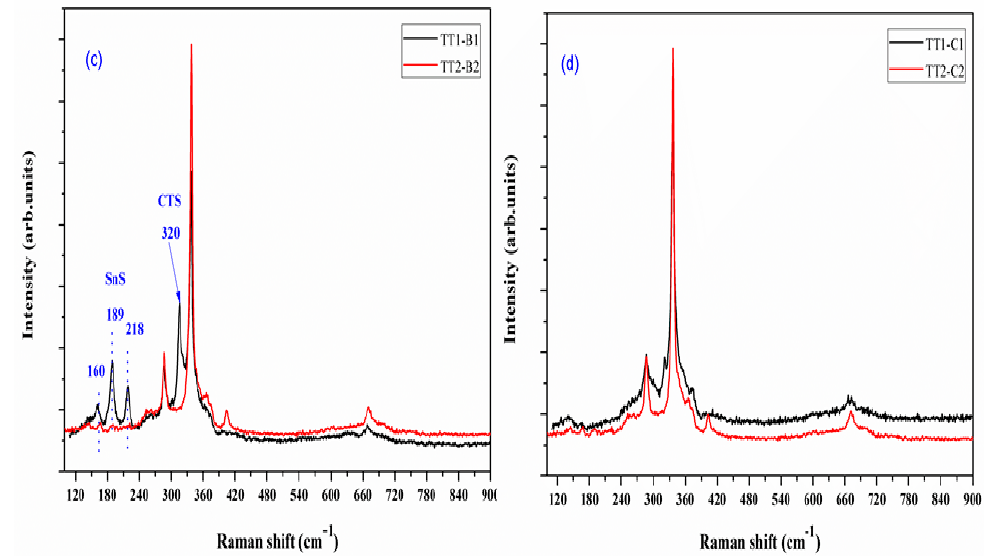
Figure 3. Raman spectra of sample at different thermal treatments: ( a ) TT0, ( b ) TT1-A1, TT2-A2 ( c ) TT1-B1, TT2-B2 and ( d ) TT1-C1, TT2-C2.